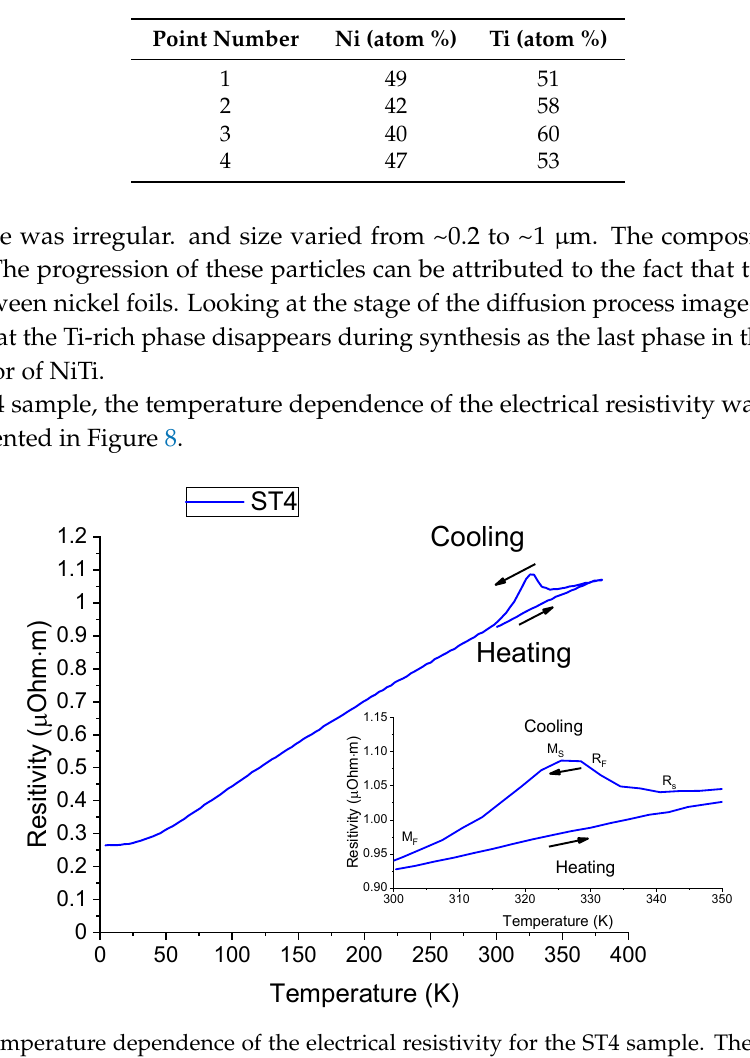
Figure 8. Temperature dependence of the electrical resistivity for the ST4 sample. The inset shows magnification of the high temperature region with marked transition points as: R S – R phase start, R F – R phase finish, M S Martensite start and M F – Martensite finish.